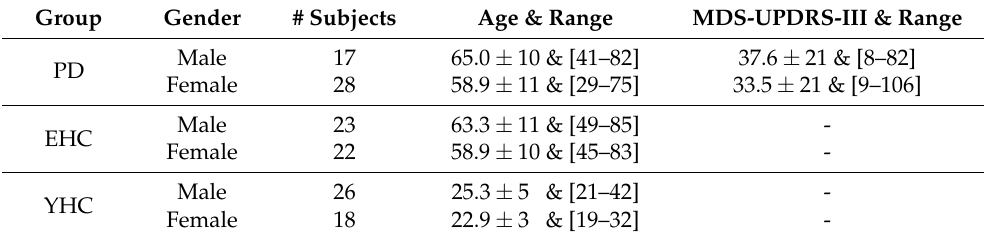
Table 1. Details about the